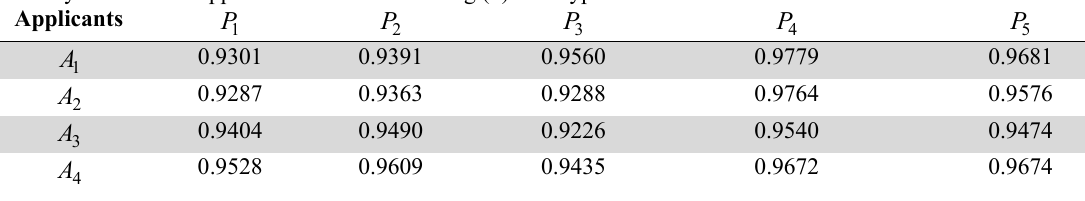
Similarity measure of Applicants vs. Positions using (6) and Type-1 score